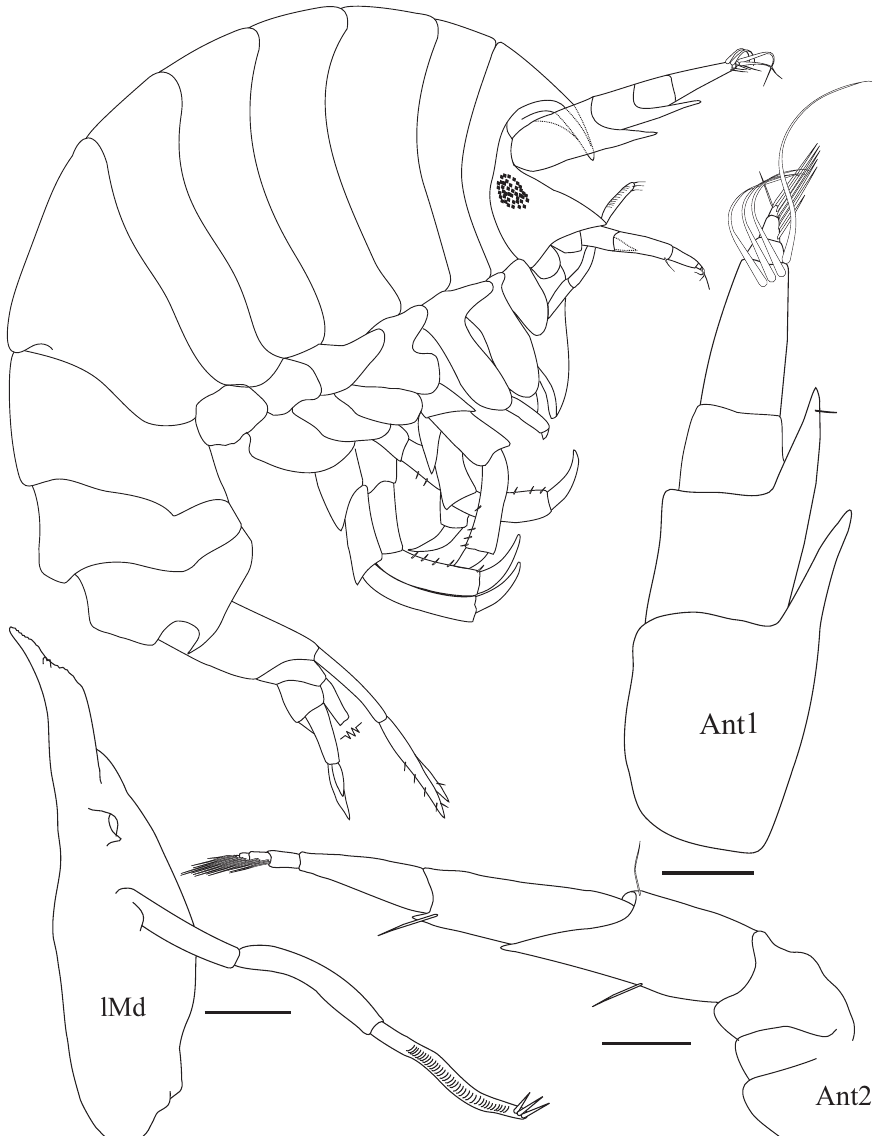
Fig . 2. – Curidia wakabarae n. sp., reVizee Benthos sCore/northeast, holotype female 2.42 mm, Fernando de noronha Chain, Pequeno island, station #88a (3.83°s; 34.71ºW), MnrJ 20868. scale bar = 0.1 mm. ant: antenna; lMd: left